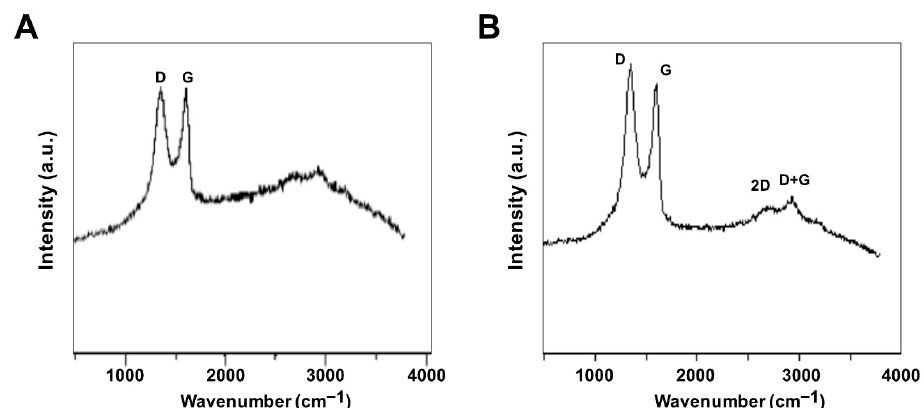
Figure 4. Characterization of GO and GO-PtNPs by Raman spectroscopy. Raman spectroscopy images of GO ( A ) and GO-PtNPs ( B ). At least three independent experiments were performed for each sample and reproducible results were obtained.